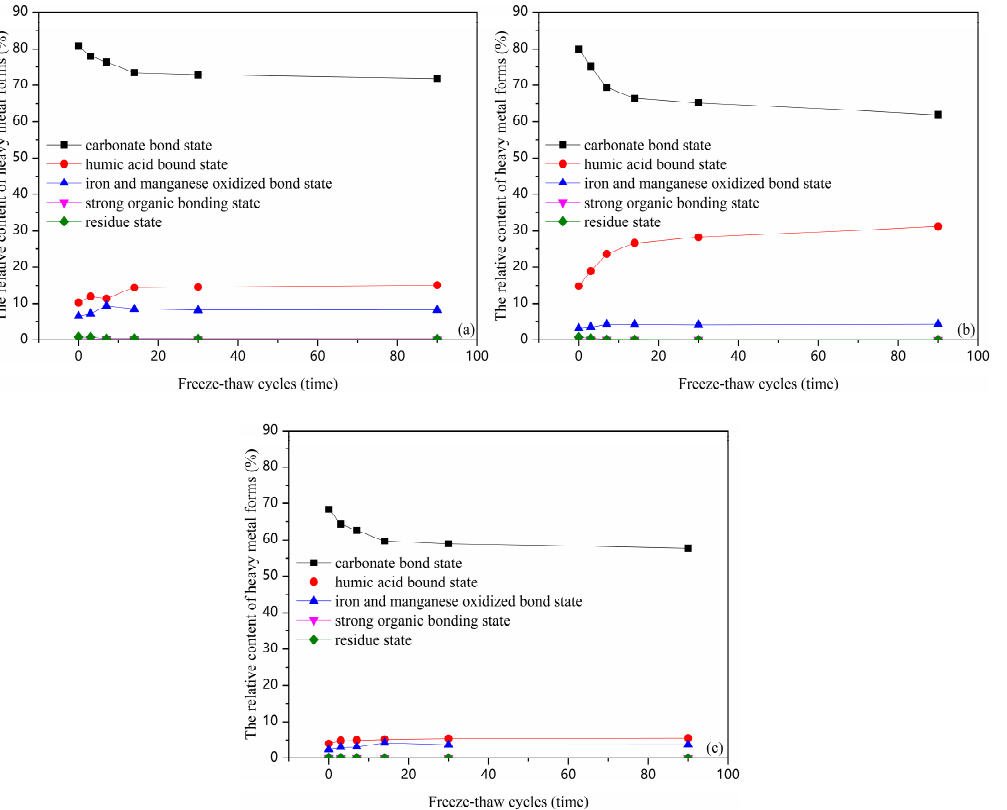
Figure 5. The variation of relative content of each speciation of HMs with F–T cycles in the S/S Pb–